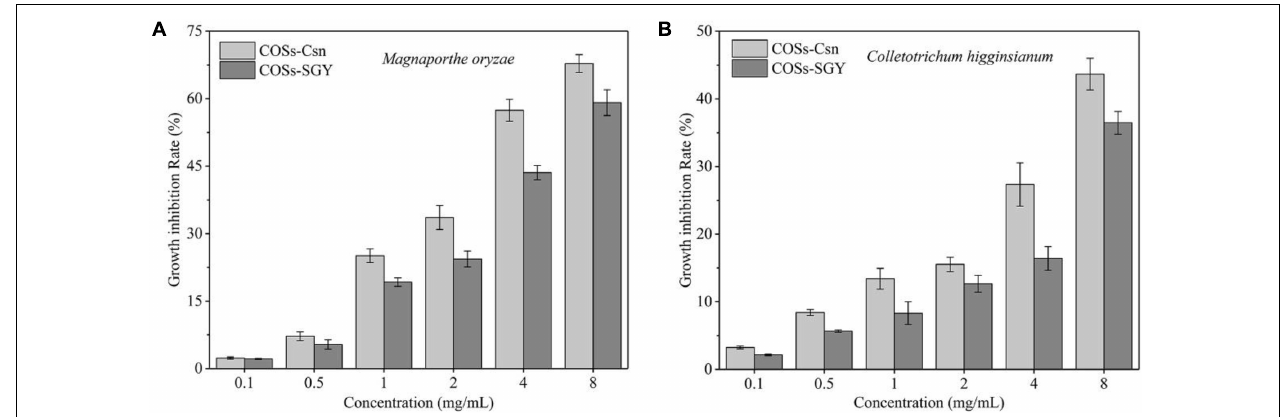
FIGURE 5 | The fungal mycelia generation inhibition rate affected by COSs at different concentrations. (A) Inhibition of mycelia generation in M. oryzae treated with COSs at different concentrations. (B) Inhibition of mycelia generation in C. higginsianum treated with COSs at different concentrations. COSs-Csn indicated the COSs prepared with Csn-SH, whereas COSs-SGY represented the COSs purchased from Guangzhou SGY Agricultural Science and Technology Co., Ltd.